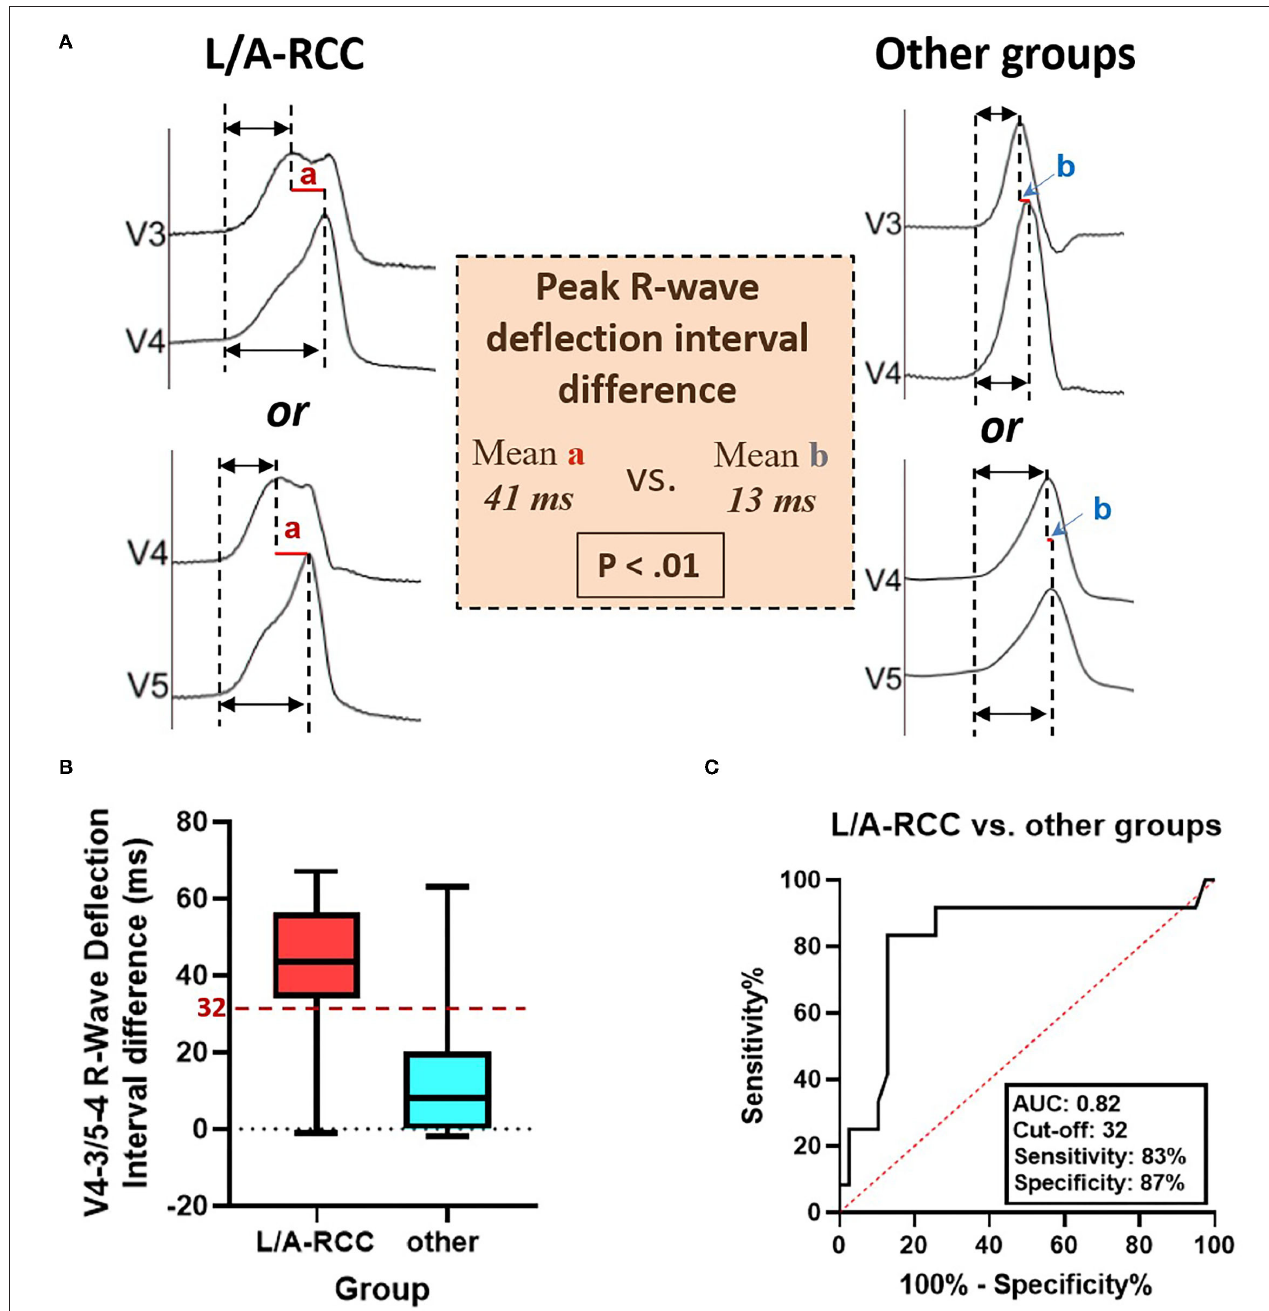
FIGURE 3 | The peak R-wave deflection interval difference between V4-V3 and V5-V4 during ventricular arrhythmias ablated in the ASVs. (A) The R-Ant./Lat. group had a longer peak R-wave deflection interval difference between V4-V3 and V5-V4 than other groups. (B) The box-and-whisker plots show the V4-V3 or V5-V4 peak R-wave deflection interval difference between R-Ant./Lat. and other groups. (C) The receiver operating characteristic analysis for peak R-wave deflection interval difference between V4-V3 and V5-V4 in patients with ventricular arrhythmias ablated in the ASVs. ASV, aortic sinus of Valsalva; R-Ant./Lat., right-lateral/anterior ASV; AUC, area under the